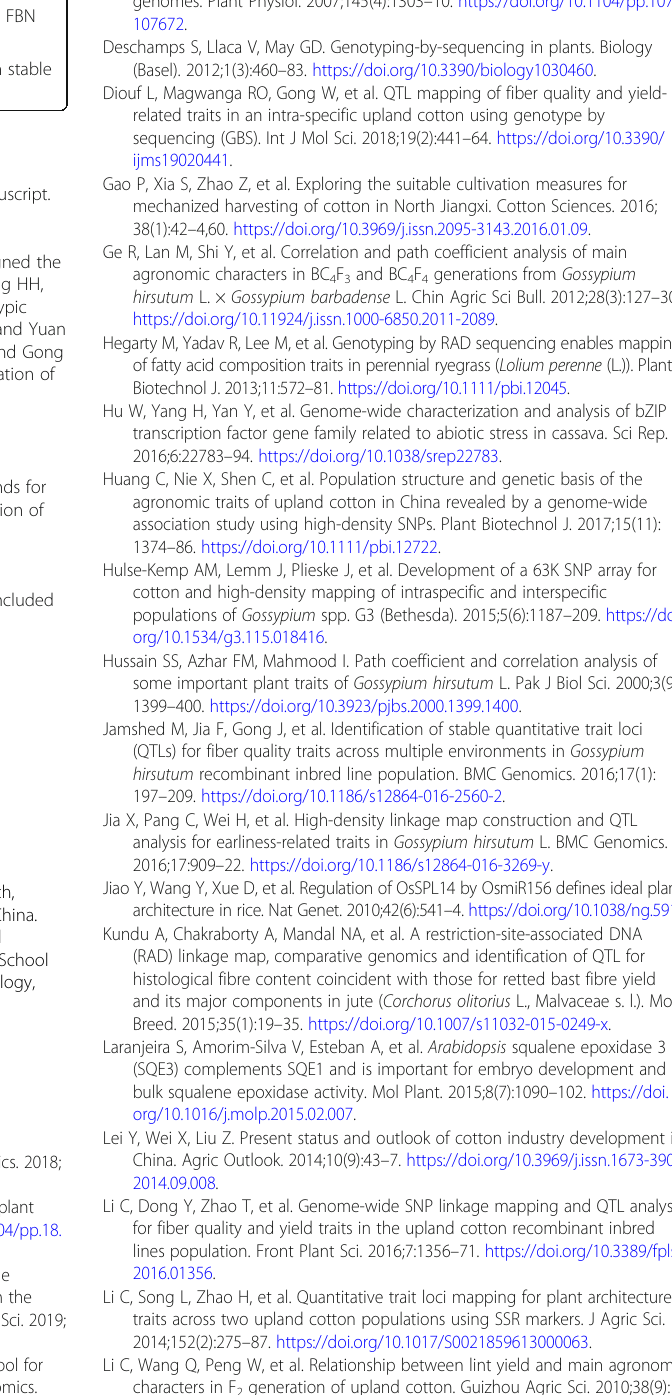
Additional file 1: Table S1. The ANOVA analysis and heritability analysis of PH and FBN traits. Additional file 2: Table S2. The QTLs for agronomic traits identified in multiple environments. Additional file 3: Table S3. Distribution of the QTL clusters. Additional file 4: Table S4. The genes in stable QTL for PH and FBN used for GO analysis. Additional file 5: Table S5. The genes in stable QTLs for PH and FBN used for KEGG analysis. Additional file 6: Table S6. The genes annotation information in stable QTLs for PH and